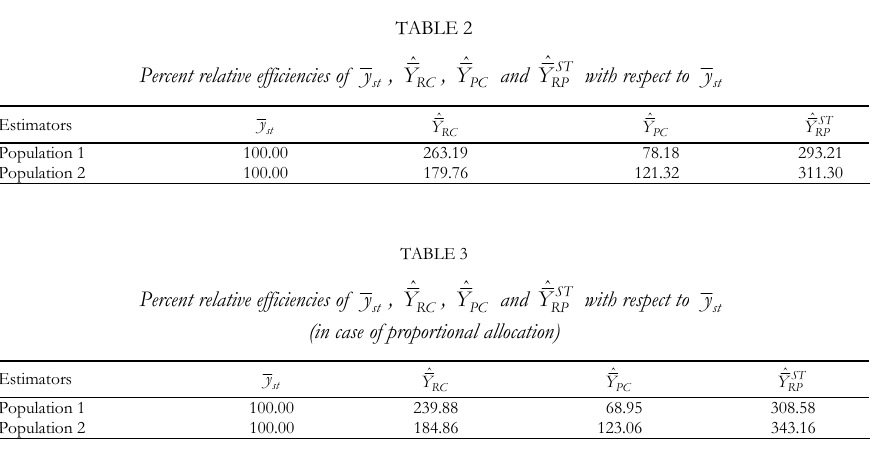
is more efficient than